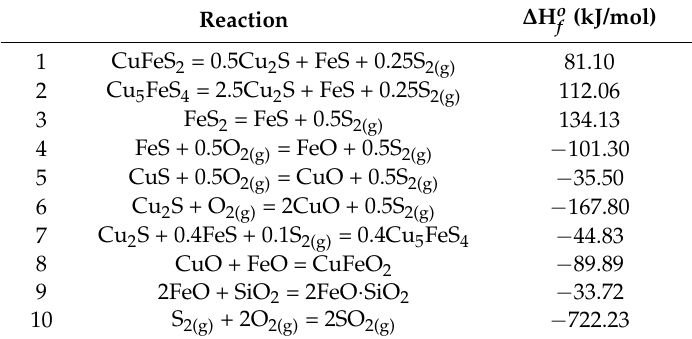
Table 3. Typical reactions during concentrate flash oxidation 1